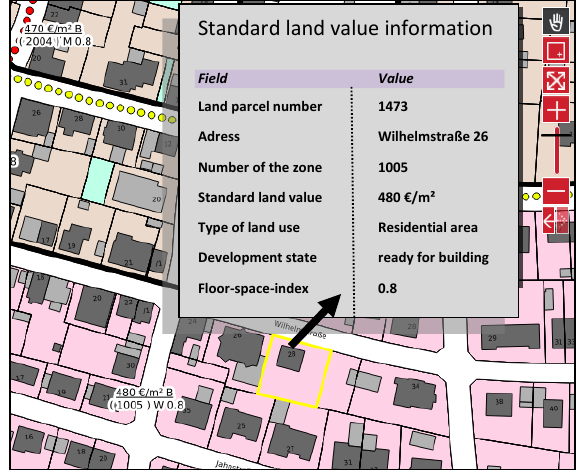
Figure 6. Configured popup dialog with the relevant attributes concerning the standard land